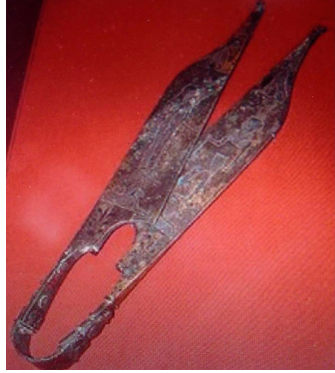
Figure 2. Comb made from wooden twigs.